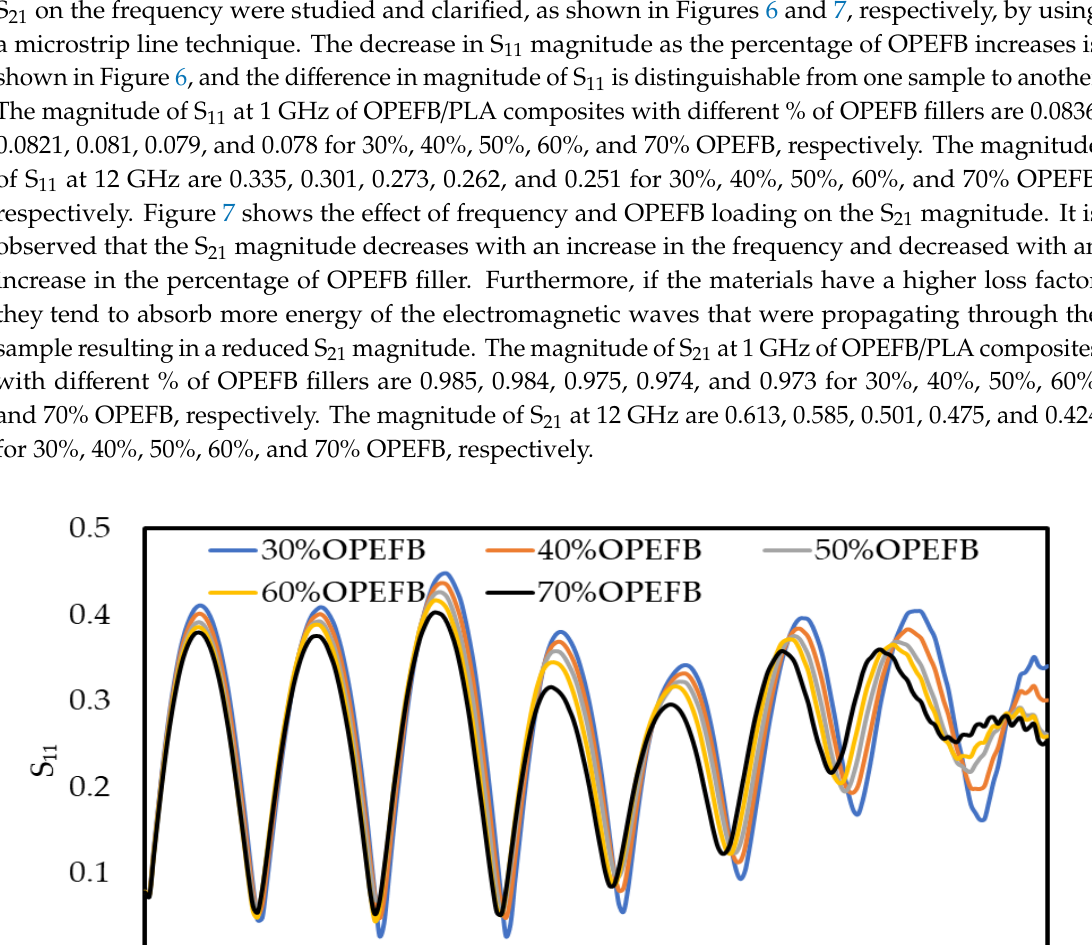
/ PLA composite at di ff erent percentages of 11 ) for OPEFB